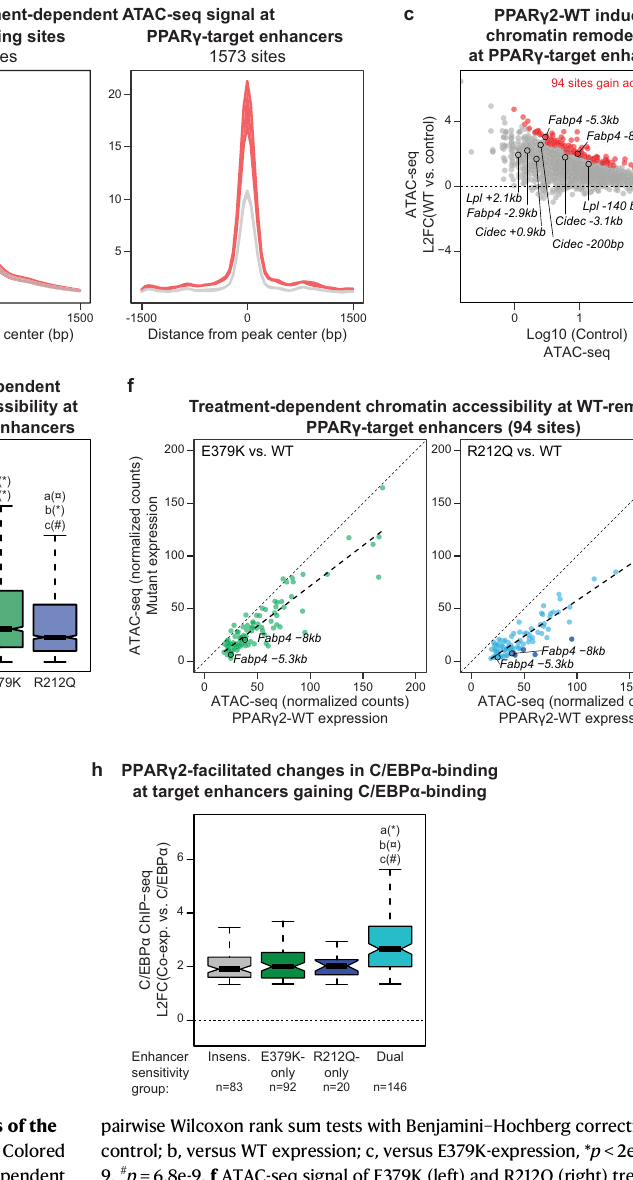
(Fig.6c).Basedonthis,wede fi ned ’ PPAR γ -targetenhancers ’ asthe1573 putative enhancers that gain H3K27ac and/or Med1 in response to PPAR γ binding. Importantly, PPAR γ -target enhancers display higher average PPAR γ occupancy and a stronger PPRE motif, compared with the other binding sites (Fig. 6d, e), and the top-scoring de novo motif found within PPAR γ -target enhancers resembles the JASPAR PPRE (Fig. 6f). Taken together, this indicates that PPAR γ -activated sites are